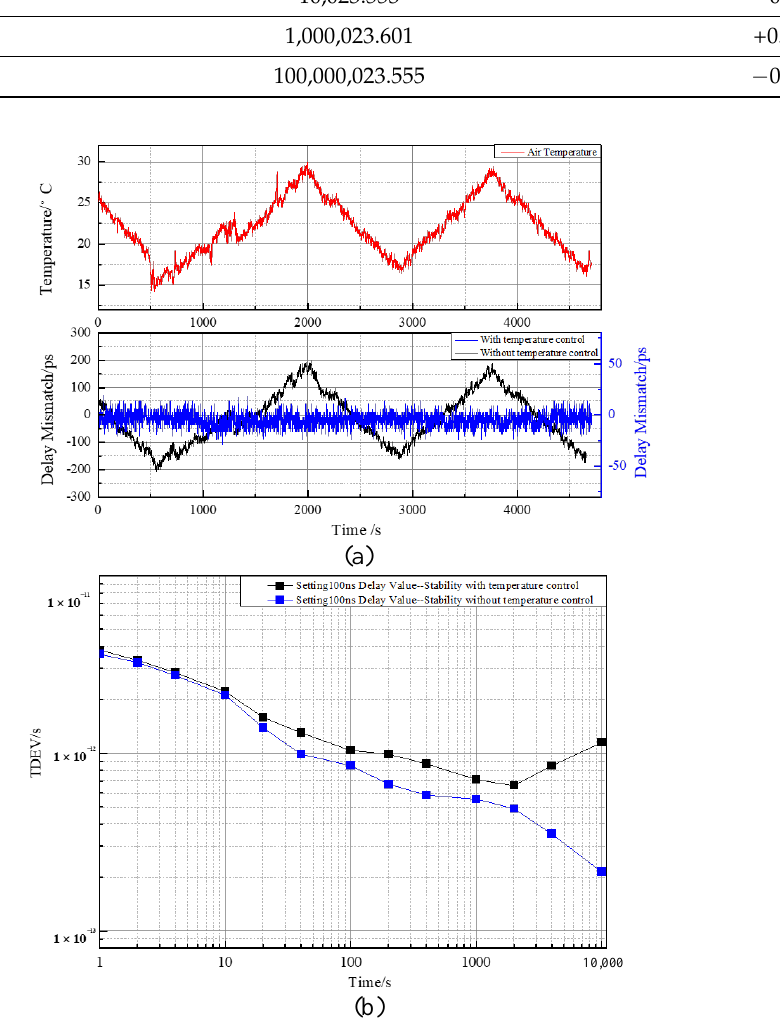
Figure 4. ( a ) Impact of temperature on the time delay compensation system performance. ( b ) TDEV results of the delay compensation control system for a delay of 100